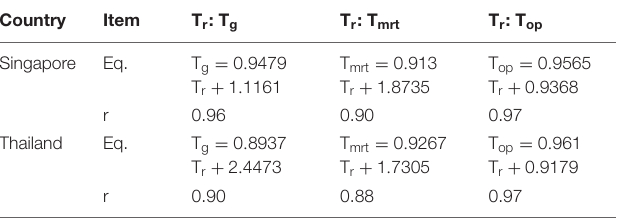
TABLE 4 | Regression equations and correlation coefficients of room temperature and other temperature variables. Country